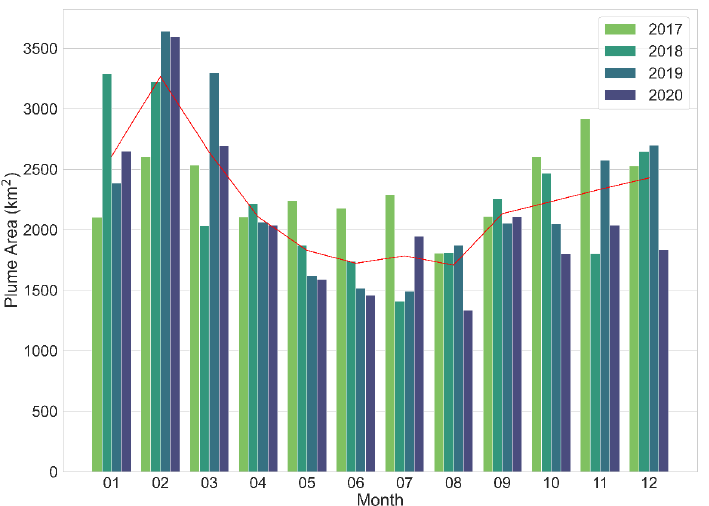
Figure 7. Total plume extent per month between 2017 – 2020 and the monthly average per year (red line) show the variability across the months in the timeseries.